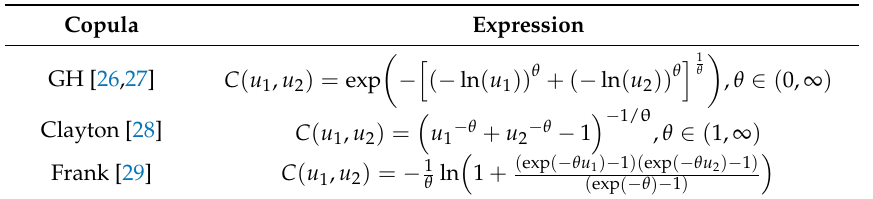
Table 1. Bivariate Archimedean Copula